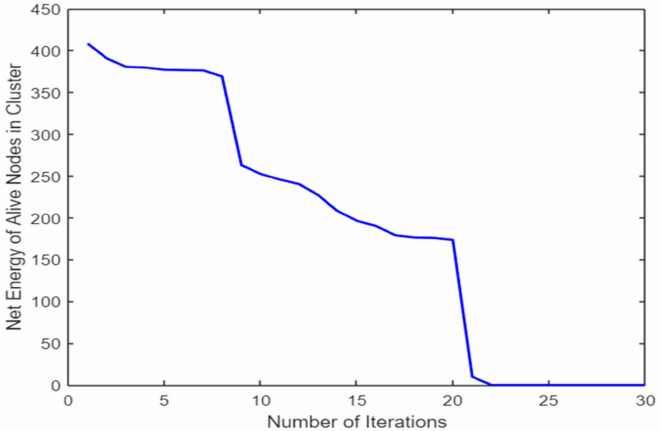
Figure 10. Decrease in total residual energy of alive nodes with the iterations as per the PSO